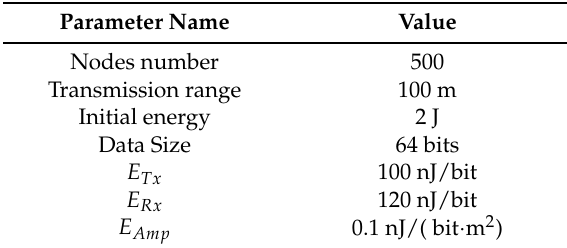
Table 4. Experimental